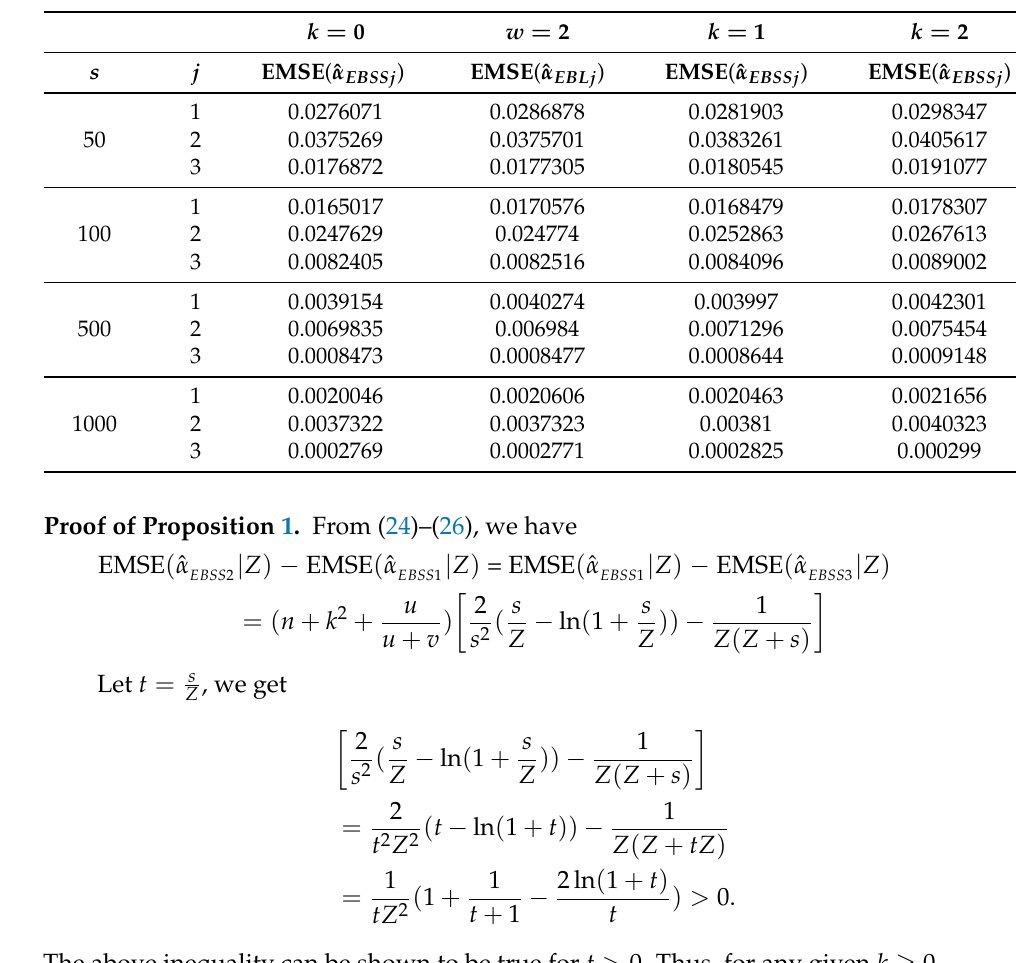
Table A6. Simulated EMSE of ˆ α with n = 50, β = 0.9, u = 3 and v =